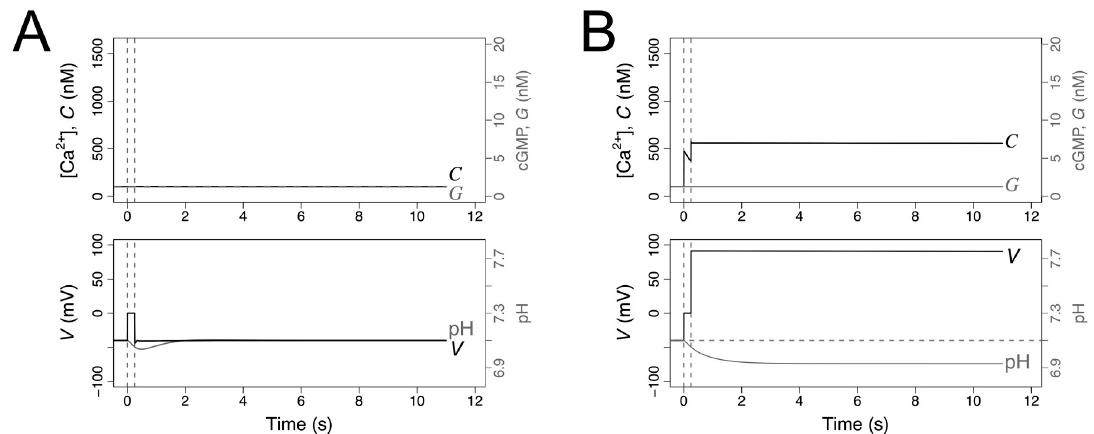
Fig 10. Ca V +BK (A) and CatSper+NHE (B) modules predict distinctive responses to manipulation of membrane potential. The graphs show the numerical solutions of the indicated variables under the reference parameters as in Figs 4 and 6. The normal resting state is perturbed (in the absence of SAP, S = 0 nM) by setting the membrane potential to a higher value ( V = 0 mV) at time t = 0 for a short period of 0.25 s (indicated by the two vertical dashed lines).